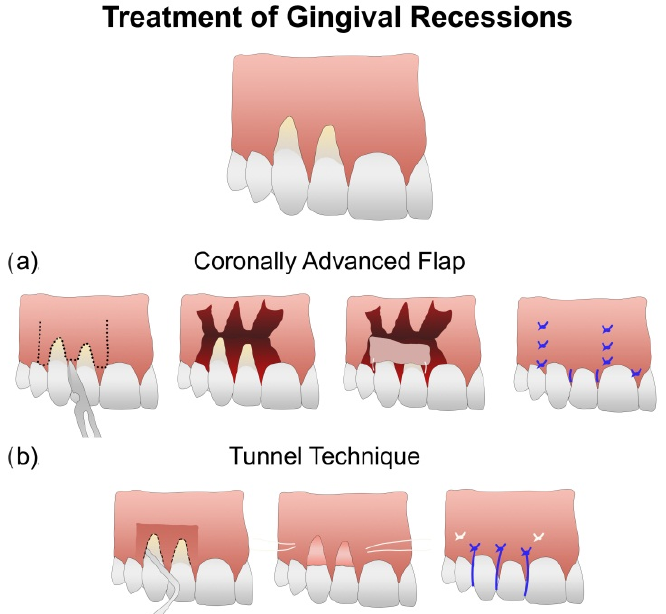
Figure 1. Illustration of the coronally advanced flap (CAF) and tunnel (TUN) surgical techniques for the treatment of gingival recessions. ( a ) CAF involves a flap elevation combining full and split thicknesses followed by the application of a connective tissue graft (CTG) or a polymeric substitute (PolS), which are then sutured over the root surfaces. ( b ) TUN consists of creating a supraperiosteal “envelope” or “pouch” at the gingival margins, allowing flap elevation and insertion of a connective tissue graft CTG or a PolS.